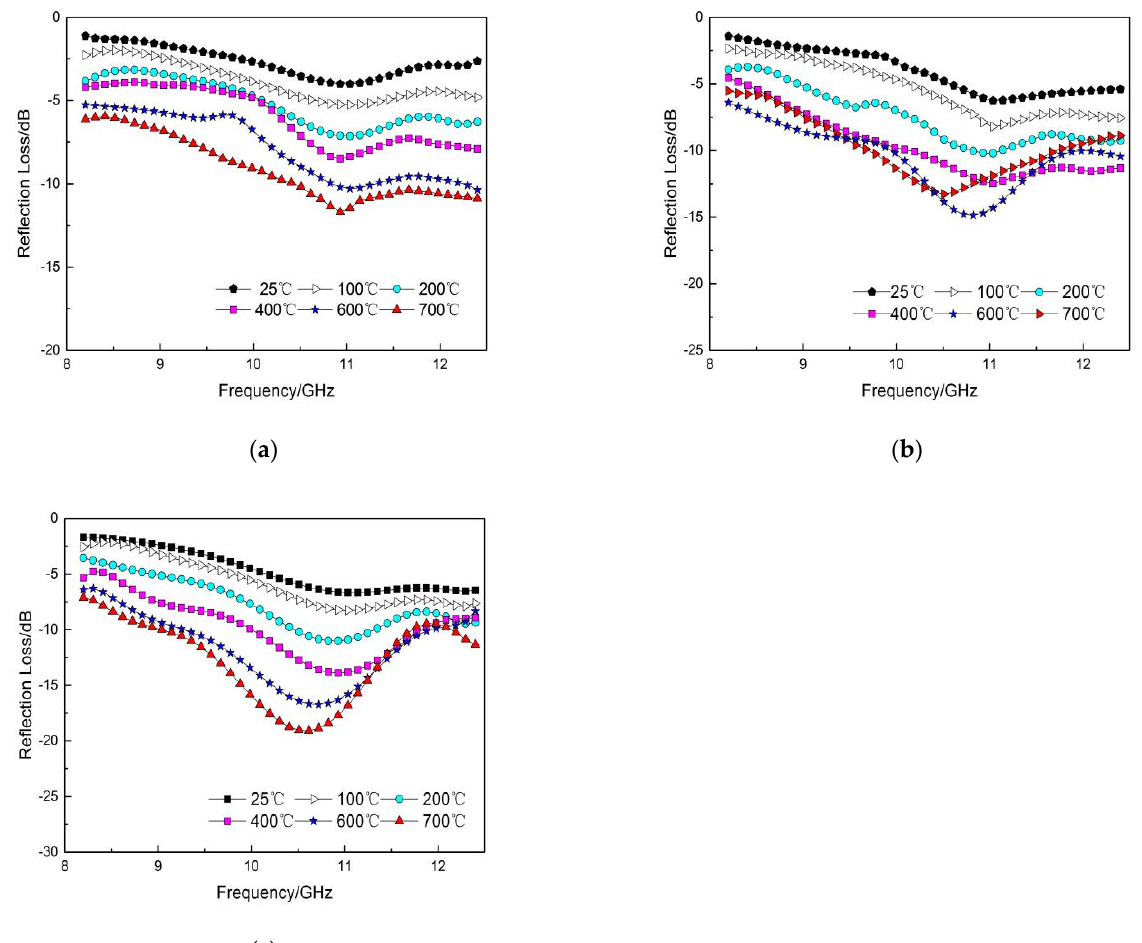
Figure 8. Reflection loss of the Al 2 O 3 –MoSi 2 /Cu composite coatings: ( a ) d = 1 mm, ( b ) d = 1.2 mm, ( c ) d = 1.4 mm. Table 3. Different coatings thickness at different temperatures, RL values, and bandwidth.